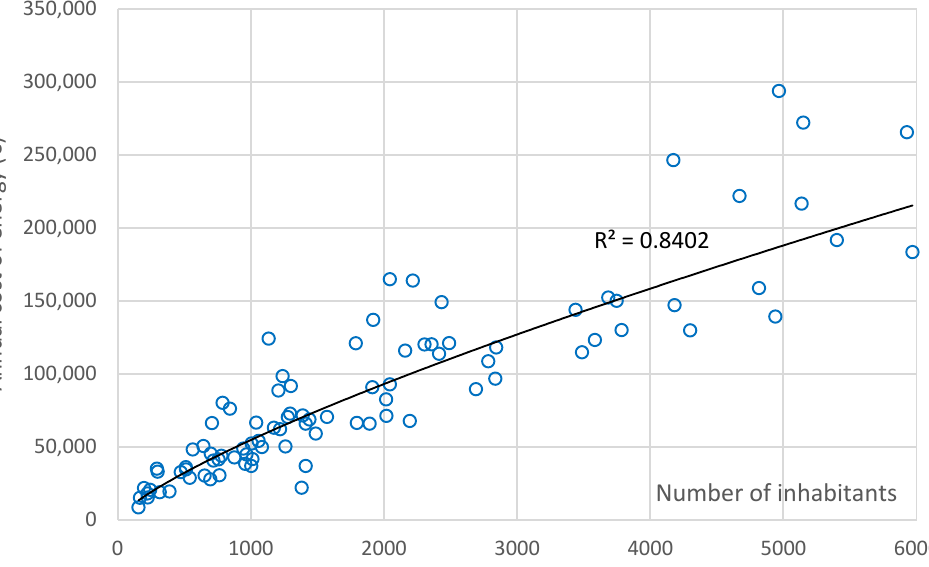
Figure 4. Annual cost of energy according to the inhabitants of a municipality.